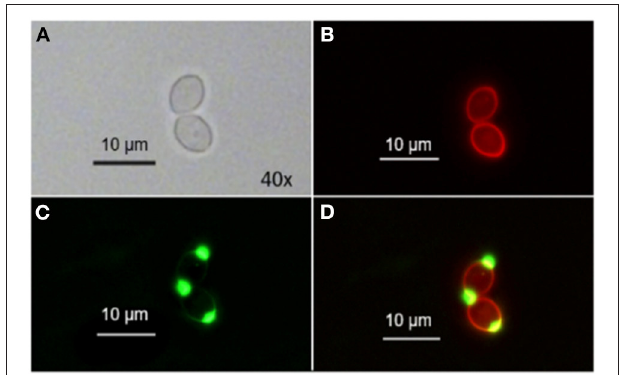
FIGURE 5 | Spatial distribution of WGA and TMPyP in C. albicans before irradiation. C. albicans cells were incubated with 50 µ M WGA and 1 µ M TMPyP for 15min and kept in the dark. Using fluorescence microscopy, we observed colocalization of fluorescence signals from WGA and TMPyP within the cell wall, but bud scars were not marked by TMPyP. (A) shows C. albicans cells incubated with WGA and TMPyP imaged by brightfield microscopy, (B) shows fluorescence signals of TMPyP within the same cells (filter: RedFP) imaged by fluorescence microscopy, (C) shows fluorescence signals of WGA within the same cells (filter: Oregon Green) imaged by fluorescence microscopy and (D) shows the overlay of both fluorescence